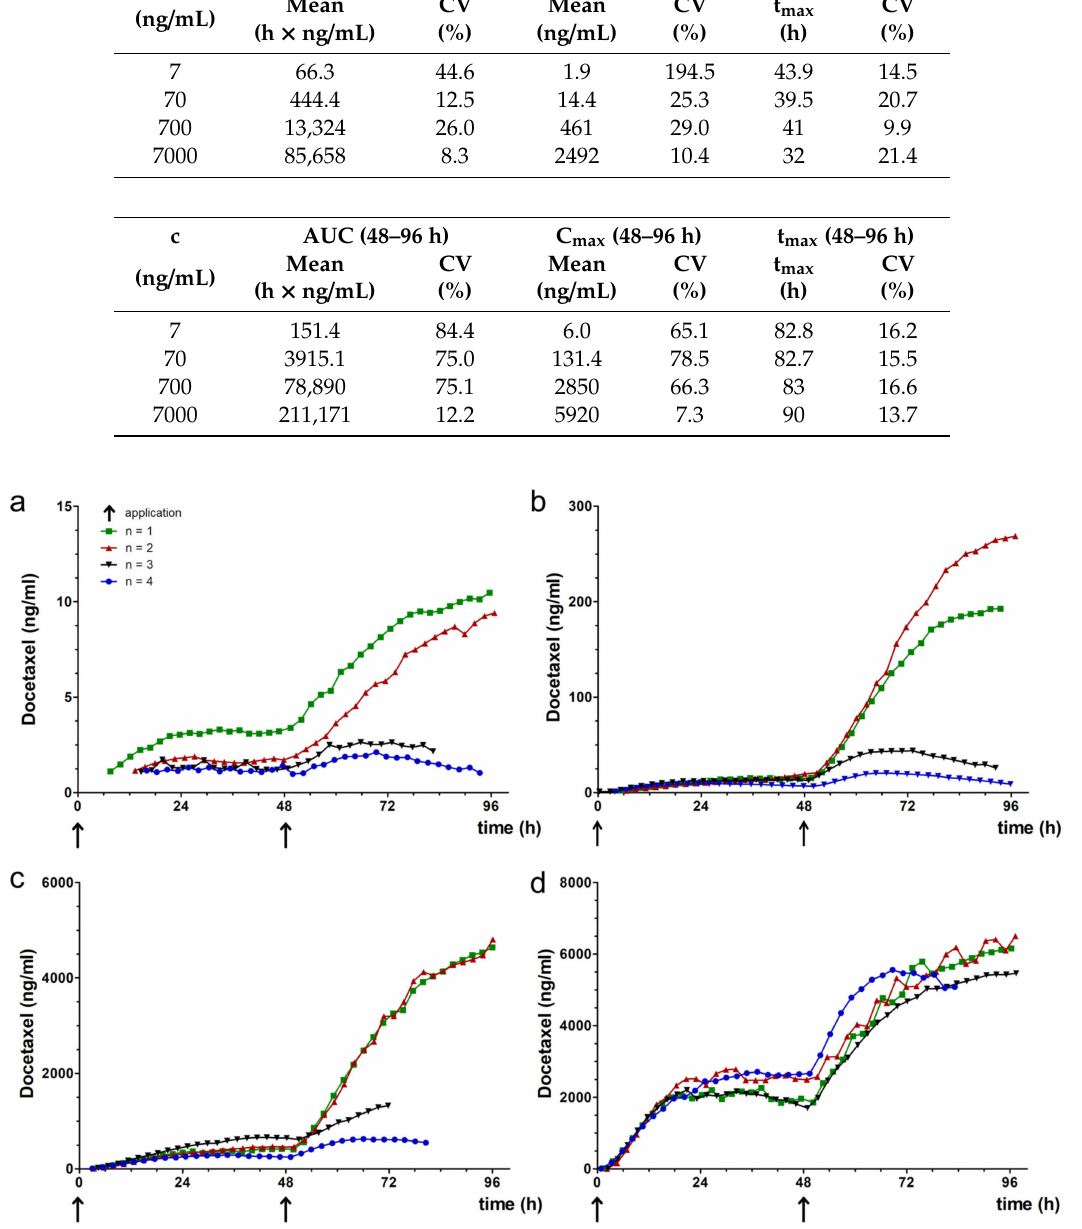
Figure 3. Concentration-time curves of docetaxel. Docetaxel concentrations in the sampling port of TOM models following the application of ( a ) 7, ( b ) 70, ( c ) 700 or ( d ) 7000 ng / mL docetaxel. Docetaxel was supplemented to the di ff erentiation at 0 and 48 h (arrows), n = 4 for each